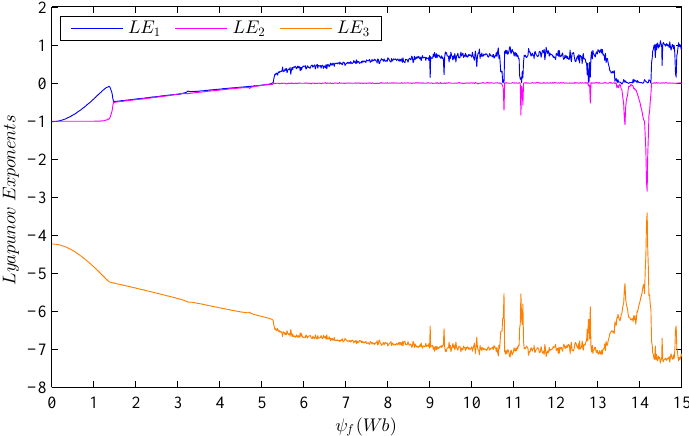
Figure 3. Lyapunov exponent spectrum of the D-SPMSG system (24) versus ψ f